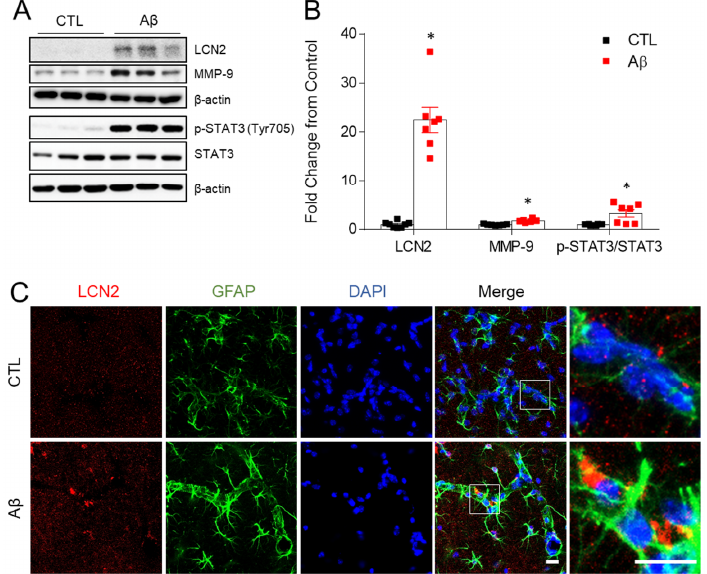
Figure 5. Effects of A β O toxicity on LCN2, MMP9, and STAT3 expression in the hippocampus. ( A ) Figure 5. Effects of AβO toxicity on LCN2, MMP9, and STAT3 expression in the hippocampus. ( A ) Figure 5. Effects of AβO toxicity on LCN2, MMP9, and STAT3 expression in the hippocampus. ( A ) Western blot analysis of LCN2, MMP-9, p-STAT3 (Tyr705), and STAT3. ( B ) Quantitation of Western Western blot analysis of LCN2, MMP-9, p-STAT3 (Tyr705), and STAT3. ( B ) Quantitation of Western Western blot analysis of LCN2, MMP-9, p-STAT3 (Tyr705), and STAT3. ( B ) Quantitation of Western blot analysis in ( A ). To normalize total protein level, β-actin was used as a loading control. The data blot analysis in ( A ). To normalize total protein level, β-actin was used as a loading control. The data blot analysis in ( A ). To normalize total protein level, β -actin was used as a loading control. The are presented as mean ± SEM. * p < 0.05 for control compared with AβO-treated mice. ( C ) Repre- are presented as mean ± SEM. * p < 0.05 for control compared with AβO-treated mice. ( C ) Repre- sentative immunofluorescence images (×200) of hippocampal CA1 regions showing LCN2 (red) and sentative immunofluorescence images (×200) of hippocampal CA1 regions showing LCN2 (red) and data are presented as mean ± SEM. * p < 0.05 for control compared with A β O-treated mice. ( C ) GFAP (green). DAPI (blue) was used to stain nuclei. Scale bar = 10 µm. GFAP (green). DAPI (blue) was used to stain nuclei. Scale bar = 10 µm. Representative immunofluorescence images ( × 200) of hippocampal CA1 regions showing LCN2 3.6. Increased Iron Dysregulation and Oxidative Stress in AD Mouse Model 3.6. Increased Iron Dysregulation and Oxidative Stress in AD Mouse Model (red) and GFAP (green). DAPI (blue) was used to stain nuclei. Scale bar = 10 µ LCN2 is an iron-modulating protein in brain [30]. Abnormal iron accumulation is associated with oxidative stress, amyloid plaque formation, apoptosis, and neuroinflam-